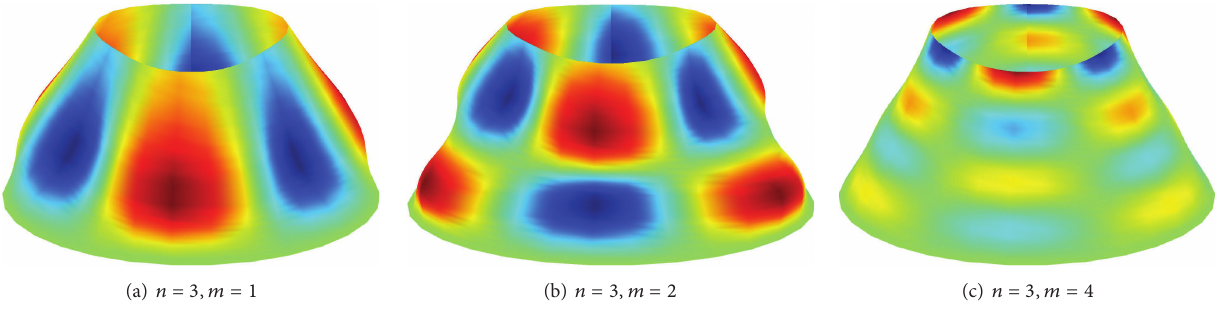
Figure 5: Modal shapes of the conical shell under F-C boundary conditions.